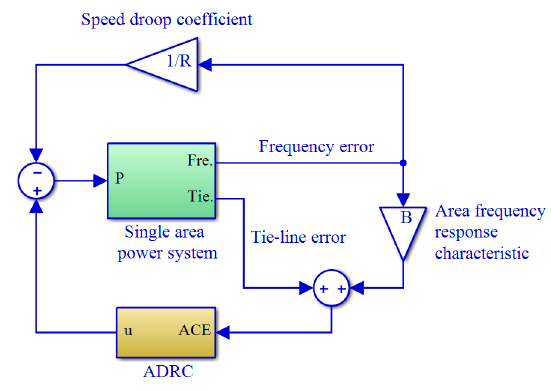
Figure 2. Block diagram of ADRC-based LFC.